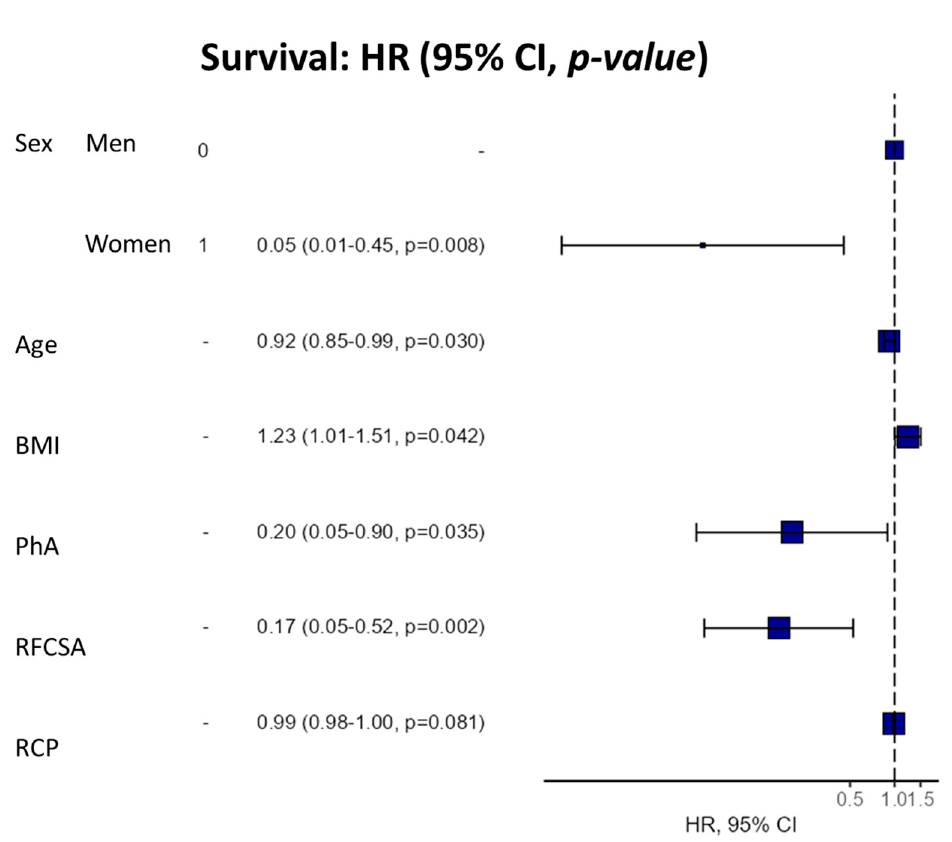
Figure 7. Hazard regression plot for survival (multivariable Cox analysis). Abbreviations. BMI: Figure 7. Hazards regression plot for survival (multivariable Cox Analysis). Abbreviations. BMI: body mass index; PhA: phase angle; RFCSA: rectus femoris cross-sectional area; CRP: C-reactive protein.